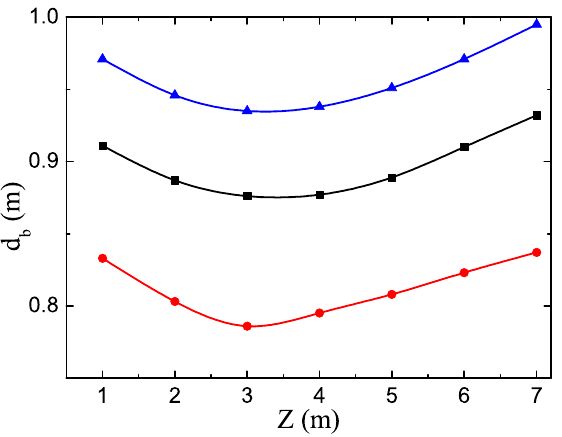
Figure 4. The size of the bubbles versus the height Z for the different conditions.